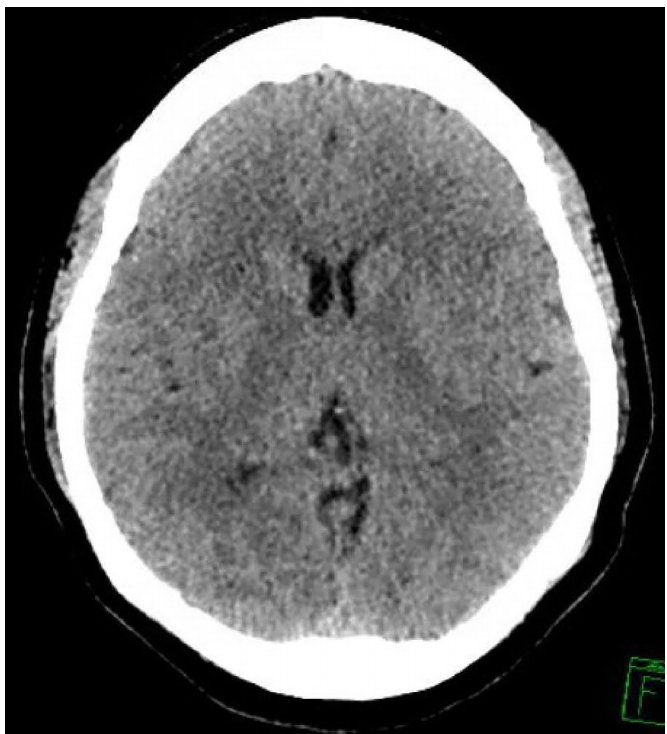
Figure 2. Computed tomography axial image demonstrating mild cerebral